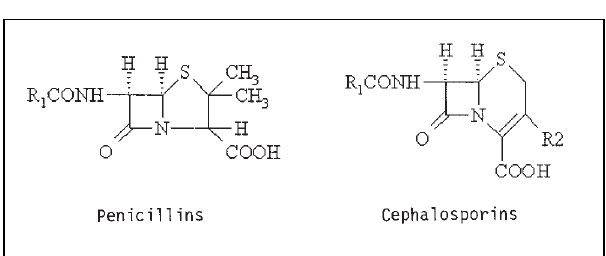
Figure 1) Comparison of chemical structure of penicillins and cephalosporins. R Side